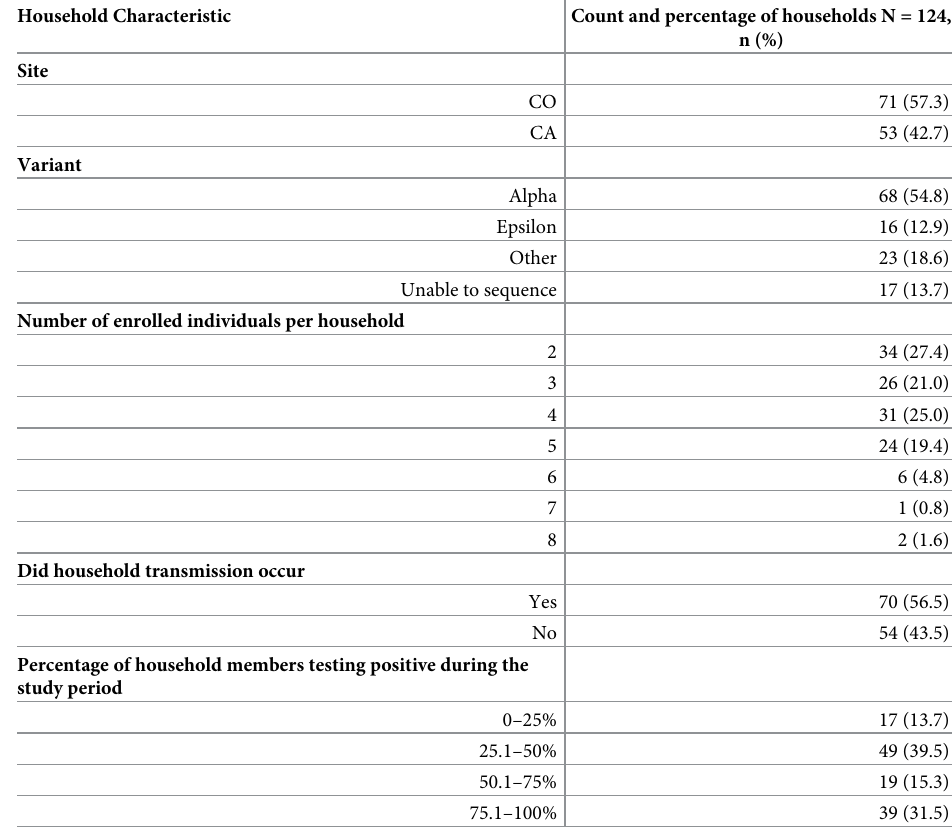
Table 1. Characteristics of households included in environmental sampling analysis. Household